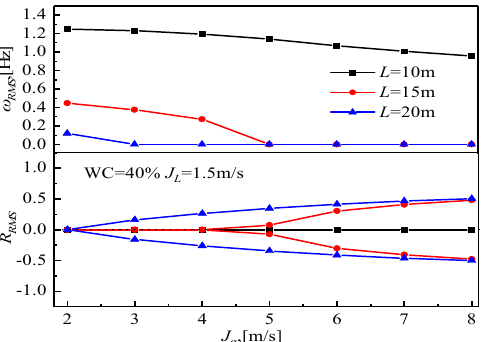
Figure 10. Variations of ω RMS and R RMS with J g and L in the first mode .